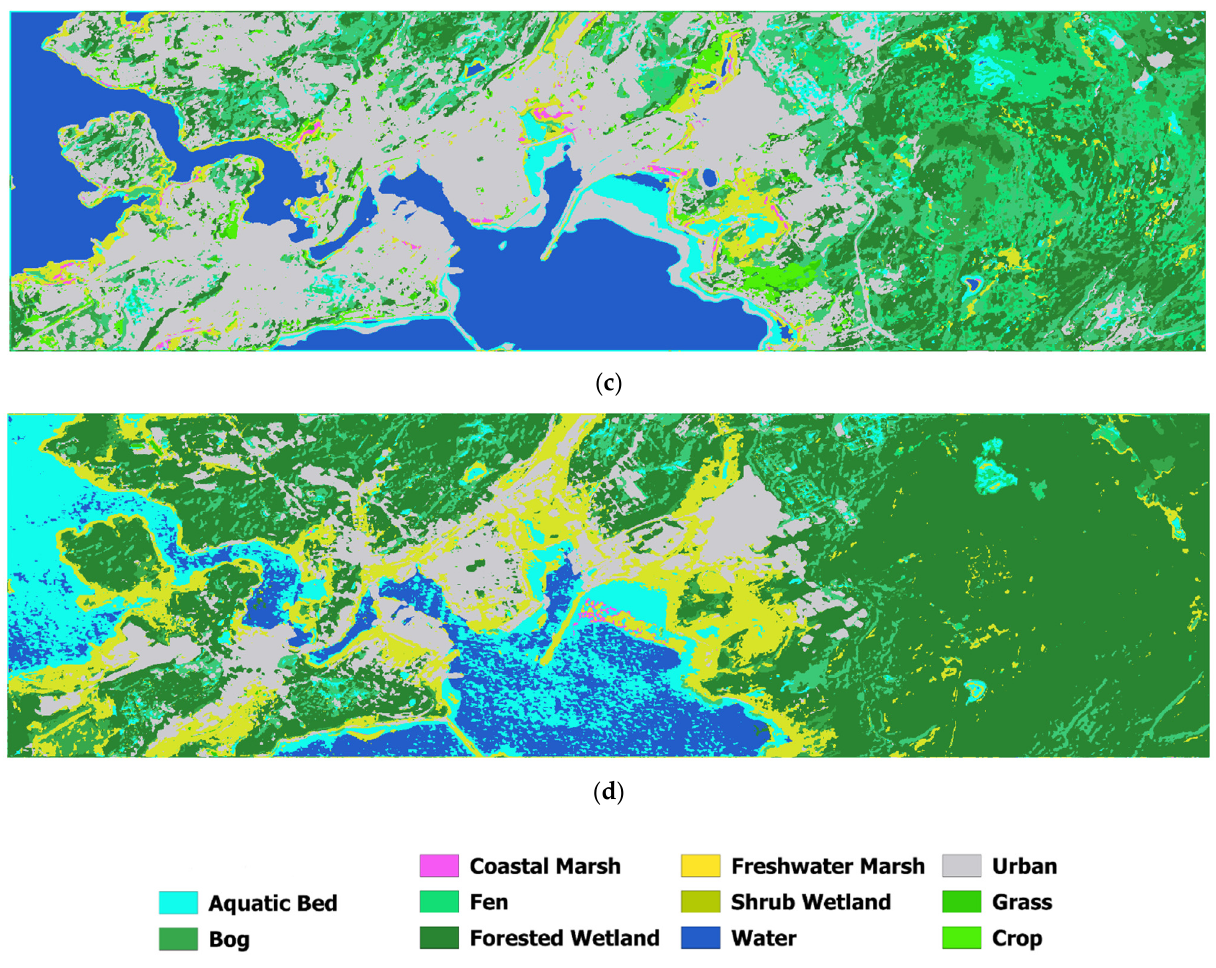
Figure 8. Coastal wetland classification using ( a ) Sentinel-2 true color of the study area of Saint John city, ( b ) the modified Swin Transformer, ( c ) AlexNet, and ( d ) VGG-16.